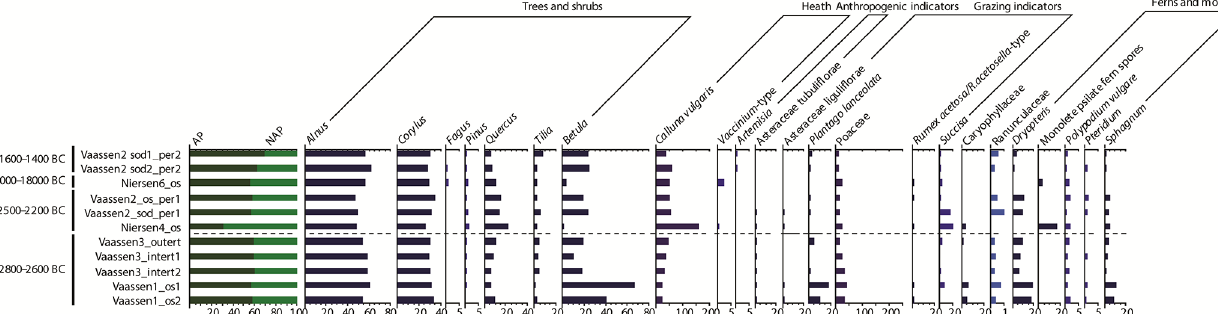
Figure 6. Pollen spectra from samples taken from the barrows at Vaassen, the barrows at Niersen barrows, and the Celtic field at Vaassen.